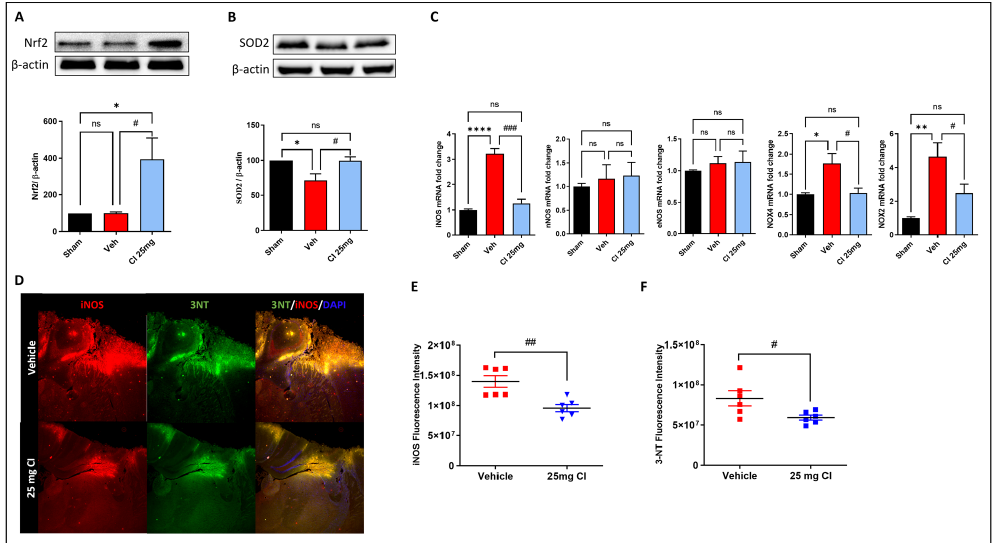
Figure 7. The effect of CI treatment on oxidative stress damage after TBI. CI increased the expression of Nrf2 ( A ) and SOD2 ( B ) in the perilesional cortex after TBI. ( C ) mRNA expression of oxidative stress markers determined by RT-qPCR showed a significant reduction in the gene expression of iNOS, NOX2, and NOX4, while there was no change in the levels of nNOS and eNOS. ( D ) Representative immunofluorescence images and quantitative analysis showed that CI significantly reduced the fluorescence intensity of iNOS ( E ) and 3-NT ( F ) in the perilesional cortex after TBI. ( n = 6 per group) Data are expressed as mean ± SEM where p < 0.05 was considered significant. * p < 0.05, ** p < 0.01, **** p < 0.0001 relative to control group. # p < 0.05, ## p < 0.01, ### p < 0.001 relative to H 2 O 2 group. (See Figure S6 for original Western blot